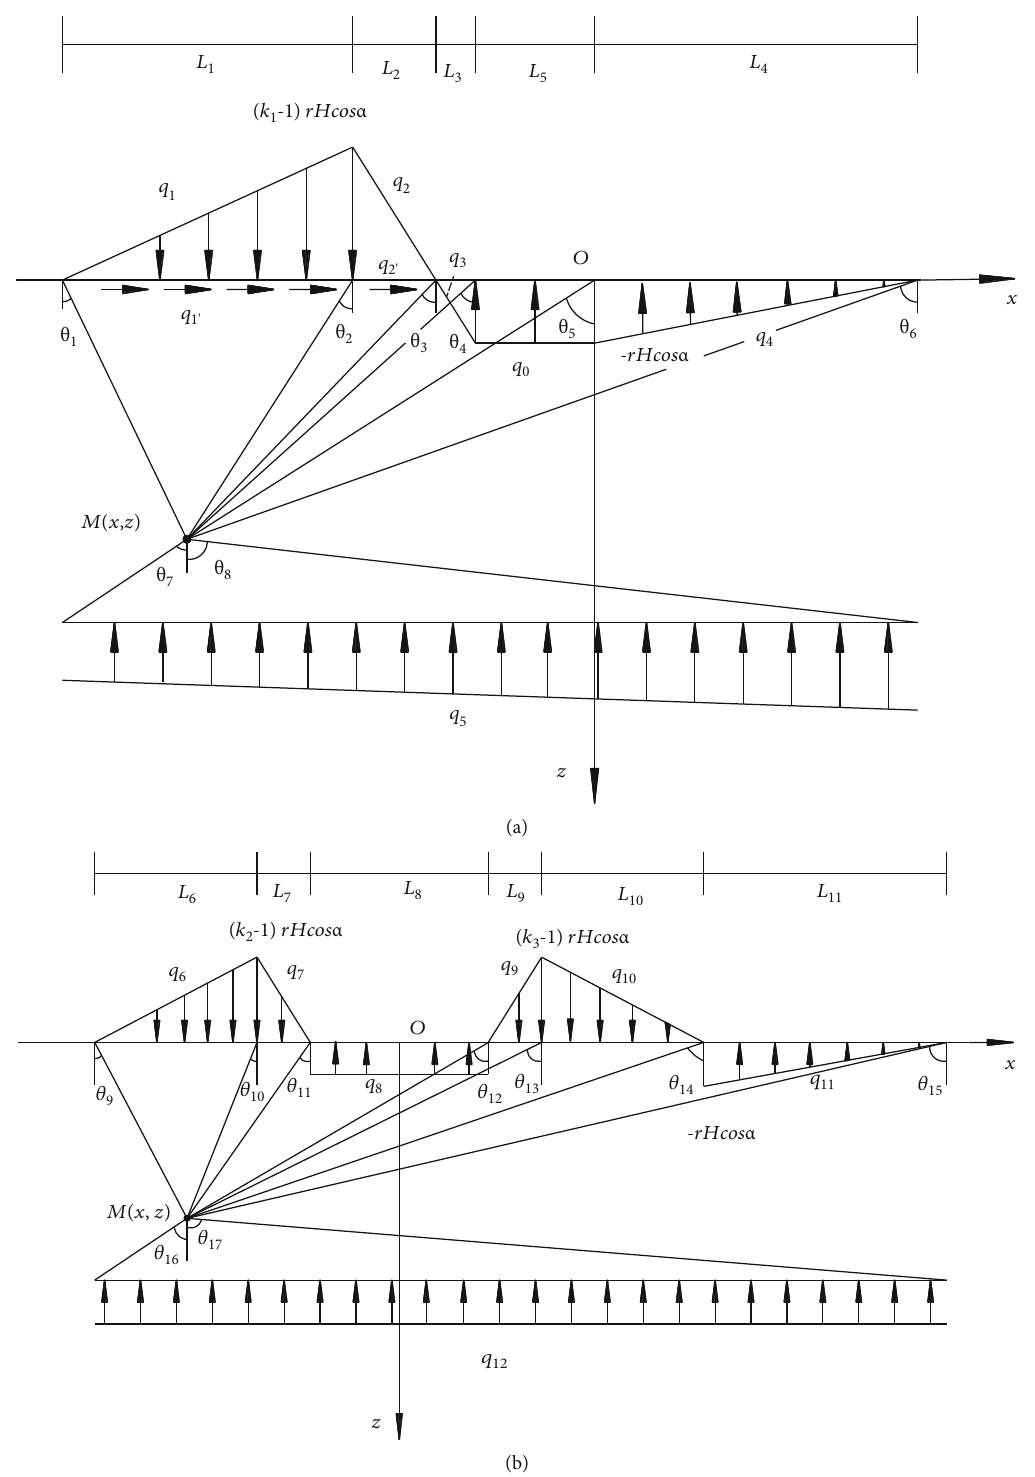
Figure 5: Mechanical models of fl oor stress in up-dip mining: (a) along the inclination; and (b) along the